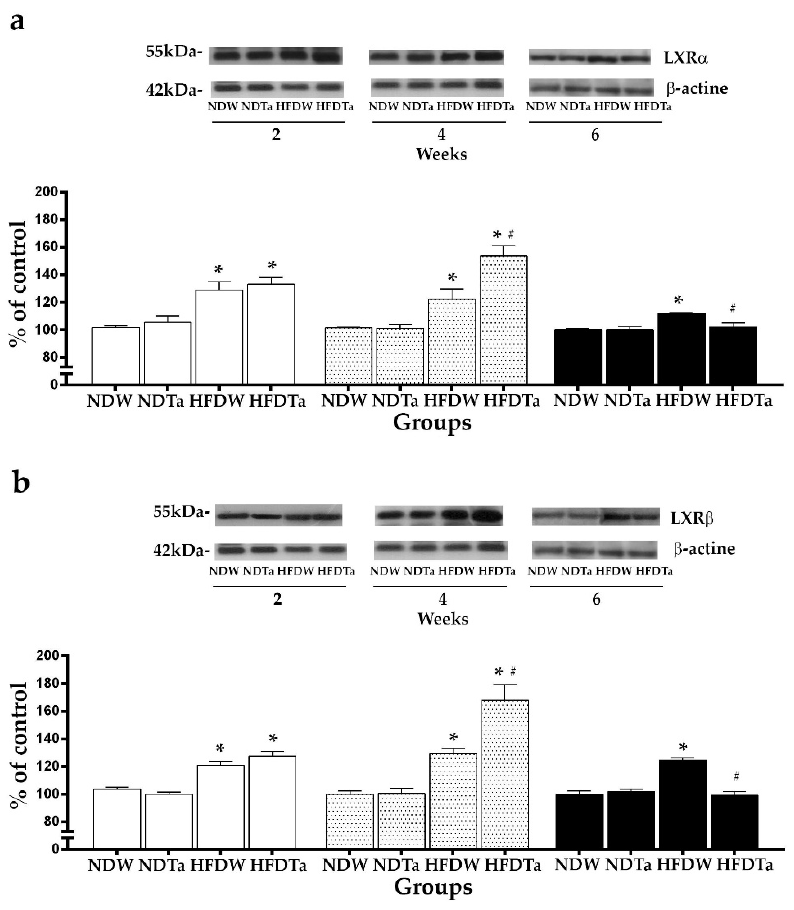
Figure 3. The expression of LXR α ( a ) and LXR β ( b ) in the liver after the administration of W or Ta for 2 (white bars), 4 (dotted bars), or 6 (black bars) weeks. The expression of LXRs was quantified by Western Blot and represented as a percentage of ND. Representative western blots are showed on the top of each graph. Results are expressed as mean ± SEM from two independent assays ( n = 5 animals/group). Significant differences were determined by two-way ANOVA followed by Newman–Keuls’ post-hoc test. * refers to each respective ND and # refers to the HFDW. * ,# p < 0.05 Newman–Keuls’ post-hoc test. Abbreviations: NDW, normal diet + water; HFDW, high-fat diet + water; NDTa, normal diet + Ta; and HFDTa, high-fat diet + Ta.